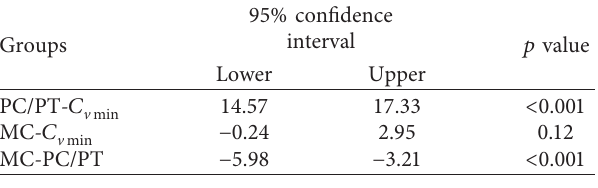
Table 8: Tukey’s HSD test results. Table 9: Thresholds for the bivariate correlation. Sr.